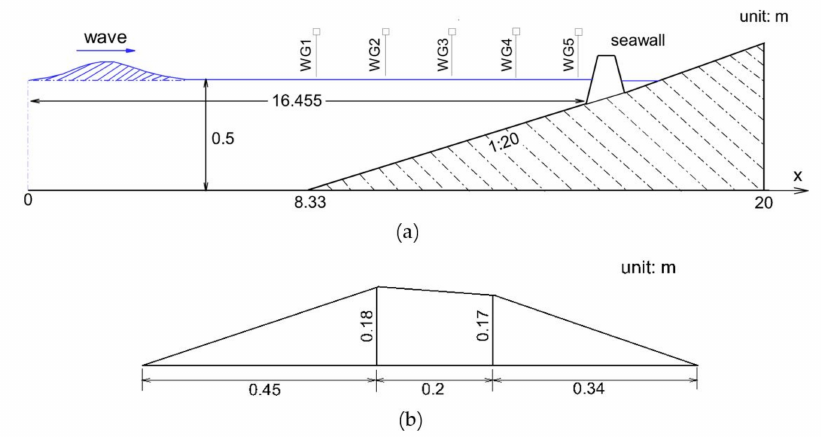
Figure 8. Experimental layout; ( a ) whole layout; ( b ) geometrical dimensions of the seawall.